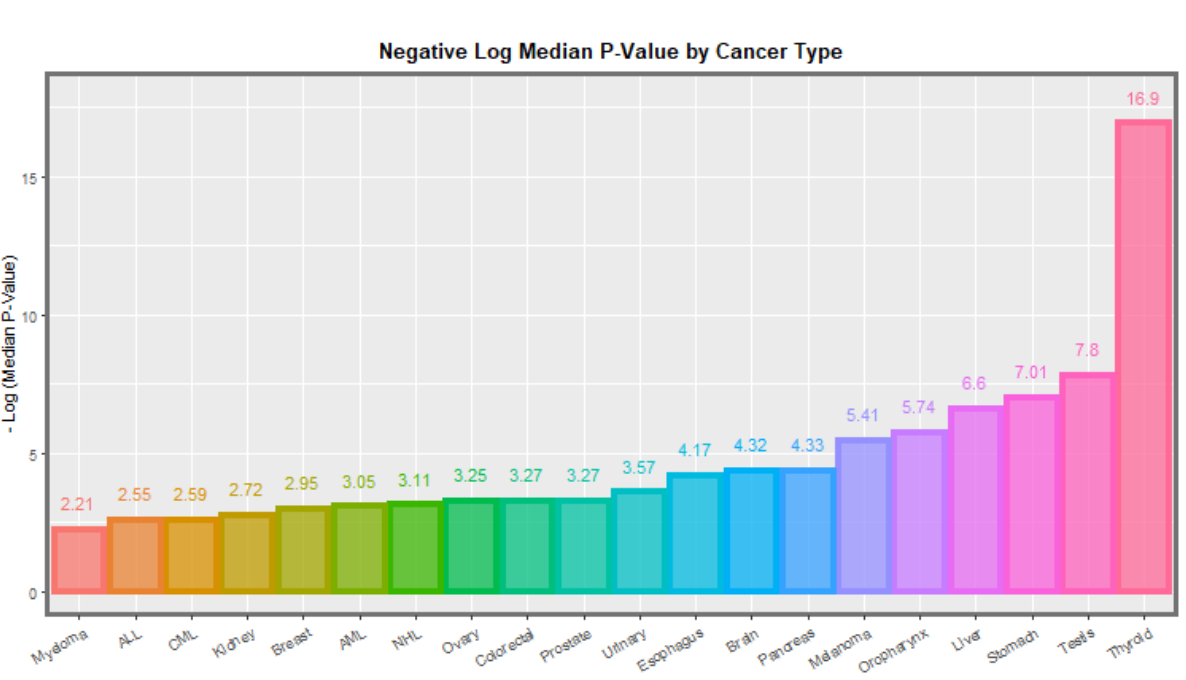
Figure 1. ( A ) Median Numbers of genes annotated and ( B ) median p -values for each cancer type for